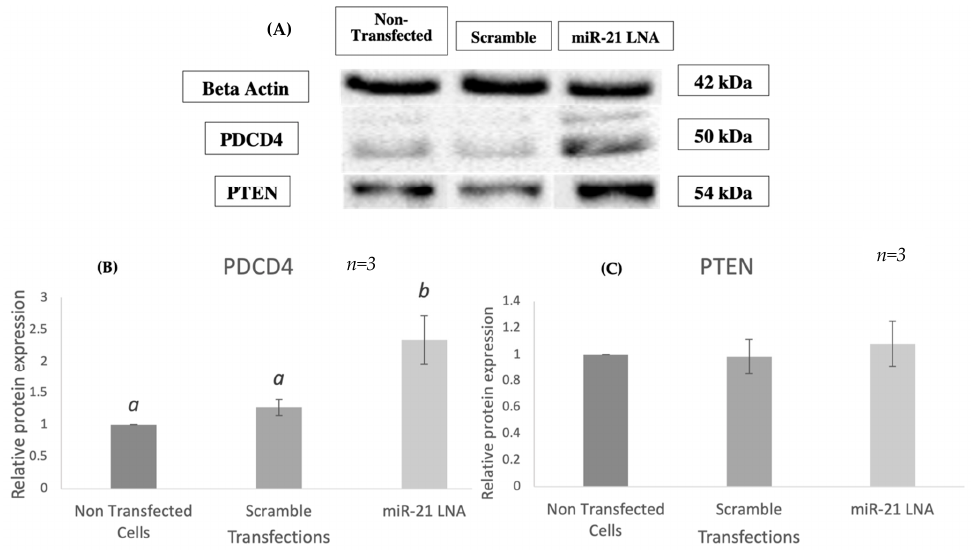
Figure 6. Relative protein expression of PDCD4 & PTEN after miR-21 inhibition . Western blots ( A ) and graphical representations of PDCD4 ( B ) and PTEN ( C ) revealed that miR-21 inhibition significantly increased PDCD4 protein levels but did not affect PTEN. Transfections were done with LNA inhibitor probes at 0.5 μ M for 12 h. Densitometric analysis was performed relative to the loading control, β -actin. PTEN representation contains lane rearrangement; full original PTEN blot is included in the Supplementary File (Figure S4). Different letters indicate significant differences, with b indicating a significantly different mean than a at p < 0.005. Bars represent the mean ± SEM.